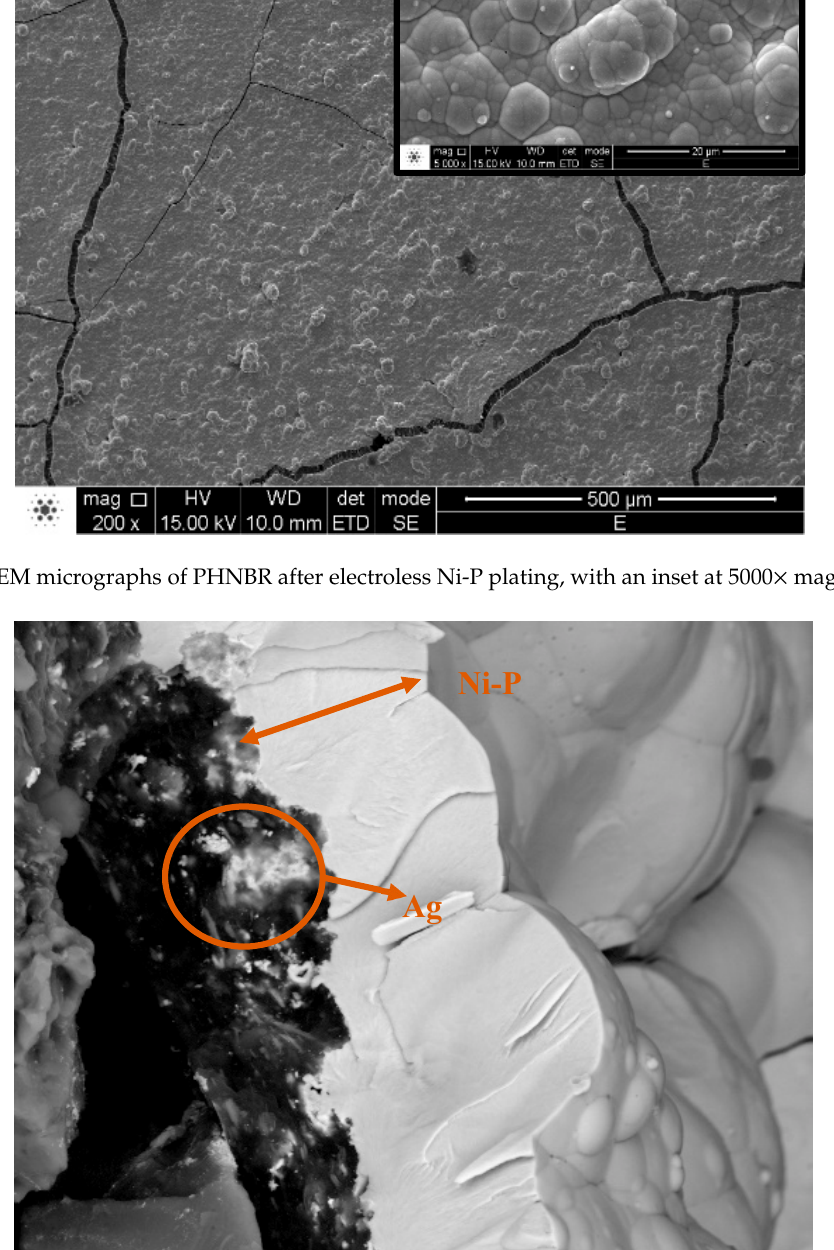
Figure 7. SEM micrograph of a cross-section of a PHNBR sample after silver nitrate activation and electroless nickel plating (ENP).